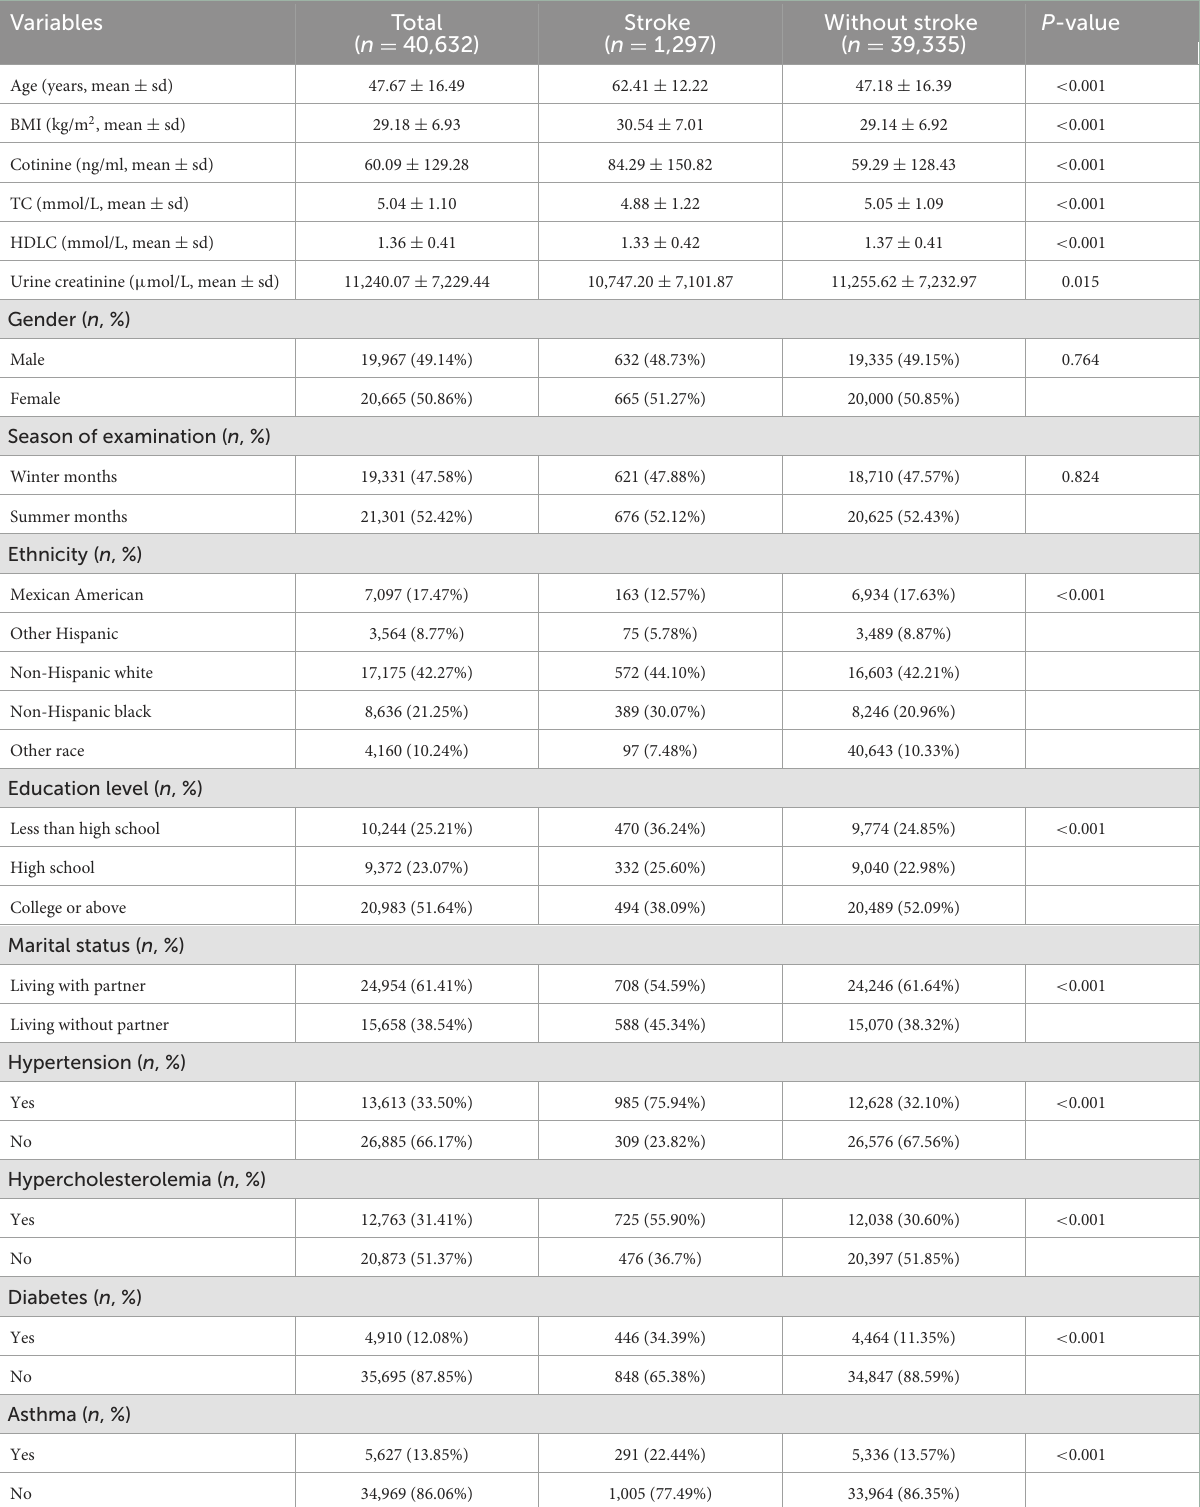
TABLE 1 Baseline characteristics of participants with complete data (no